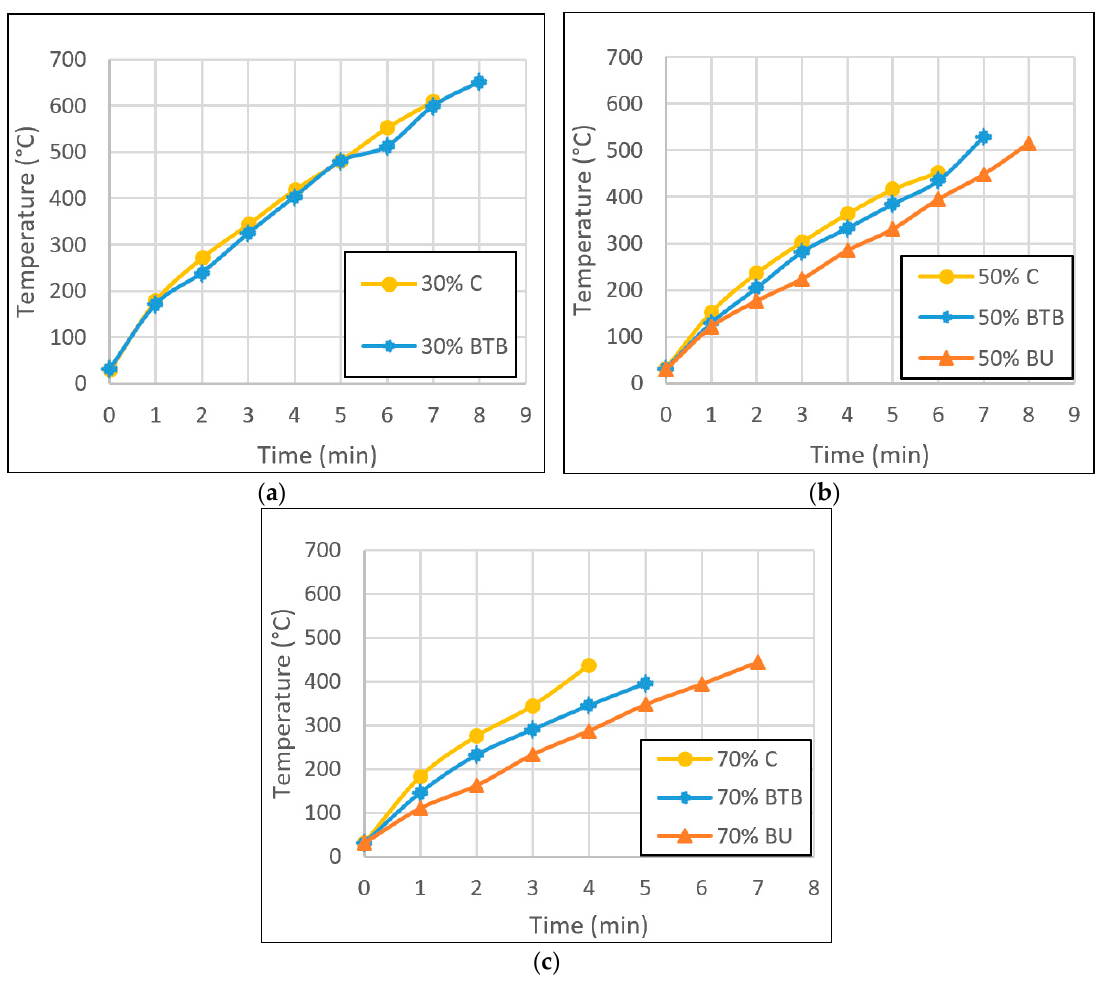
Figure 11. Effect of column type according to the degree of utilization for the temperature–time curve. ( a ) 30% degree of utilization; ( b ) 50% degree of utilization; ( c ) 70% degree of utilization.